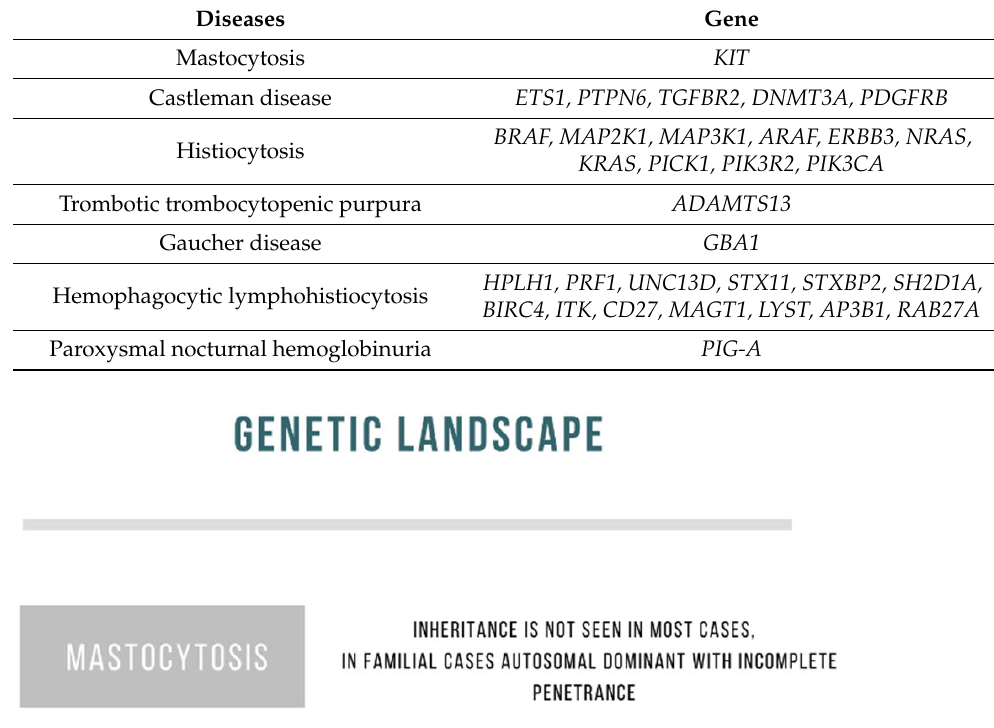
Table 1. Rare diseases in pediatric hematology and their genetic causes.